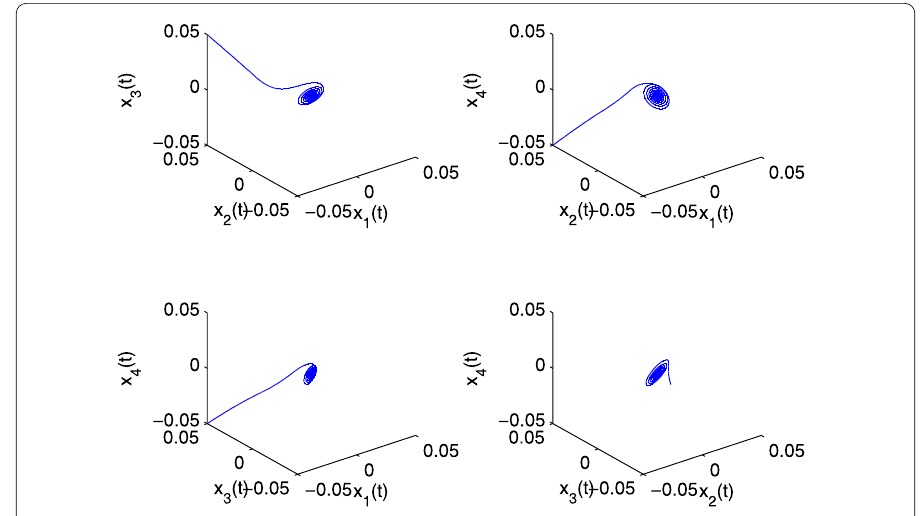
Figure 11 Phase portrait of system (5.3) with φ = 0.96, τ = 0.38 < τ 0 = 0.4486